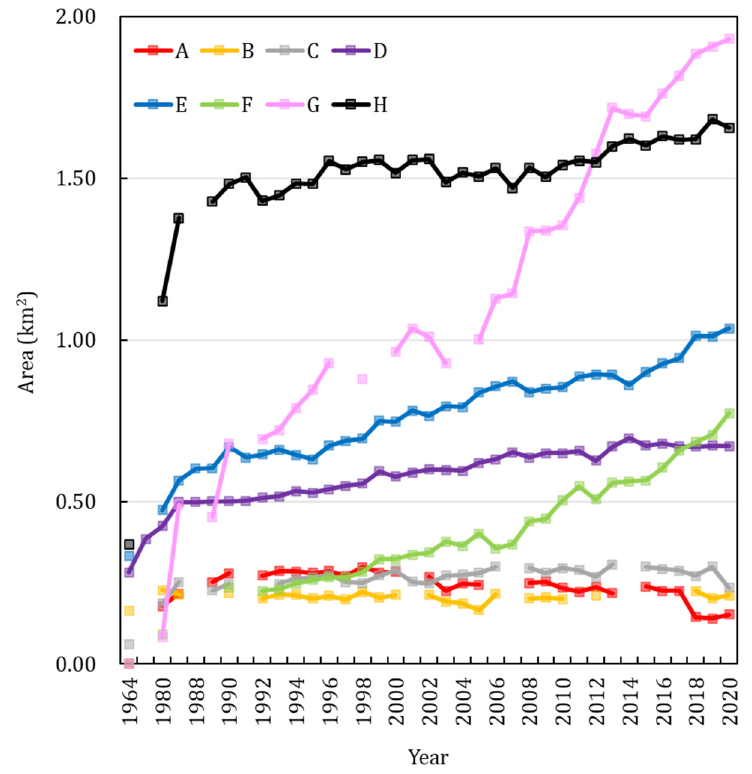
Figure 6. Area changes of eight (Lake A – H ) rapidly expanding proglacial lakes.